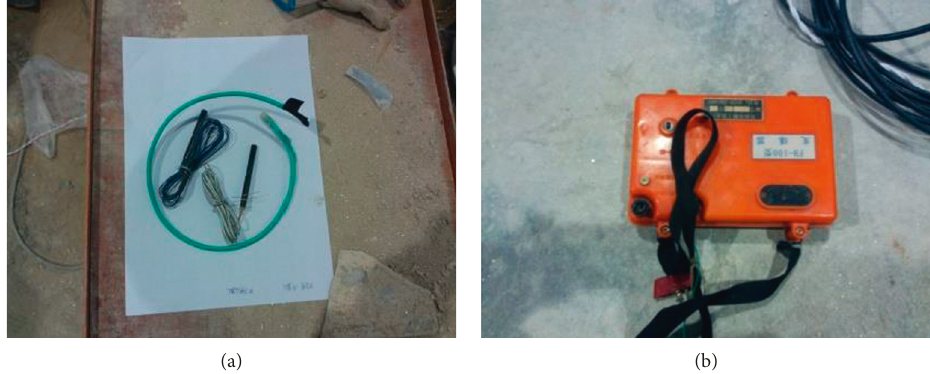
Figure 4: Blasting device. (a) RDX. (b) Initiators.